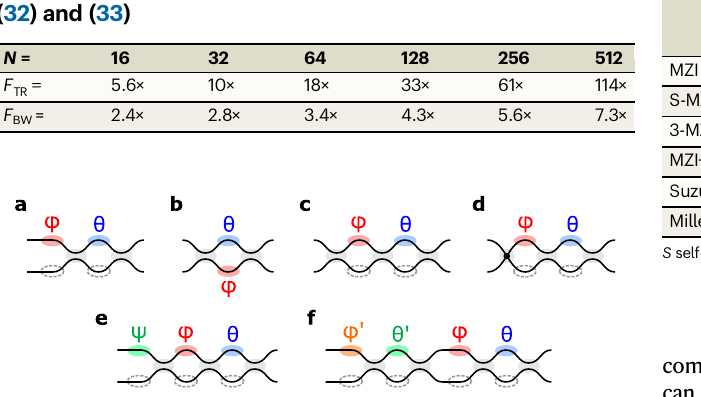
Table 1 | Approximate tuning range and bandwidth enhancement factors for mesh sizes up to N = 512, Eqs. (7),